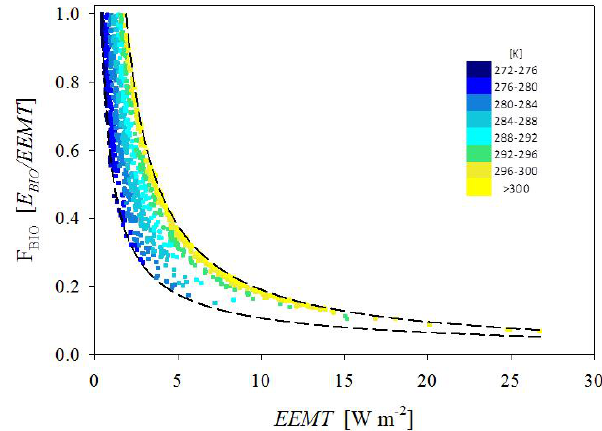
Fig. 7. The fraction ( F BIO ) of effective energy and mass transfer (EEMT) derived from primary production ( E BIO ) relative to EEMT. Figure 7. The fraction ( F BIO ) of effective energy and mass transfer ( EEMT ) derived from primary 798 Upper and lower bounds were calculated as function of tempera- production ( E BIO ) relative to EEMT . Upper and lower bounds were calculated as function of 799 ture: F BIO - T =( F BIO - ref ) T EEMT C T , where F BI0 - ref and c vary as a function of temperature ( T ). The color scale corresponds to tem- temperature: (cid:1832) (cid:3003)(cid:3010)(cid:3016)(cid:2879)(cid:3021) (cid:3404) (cid:3435)(cid:1832) (cid:3003)(cid:3010)(cid:3016)(cid:2879)(cid:3045)(cid:3032)(cid:3033) (cid:3439) temperature ( T ). The color scale corresponds to temperature. 801 802 803